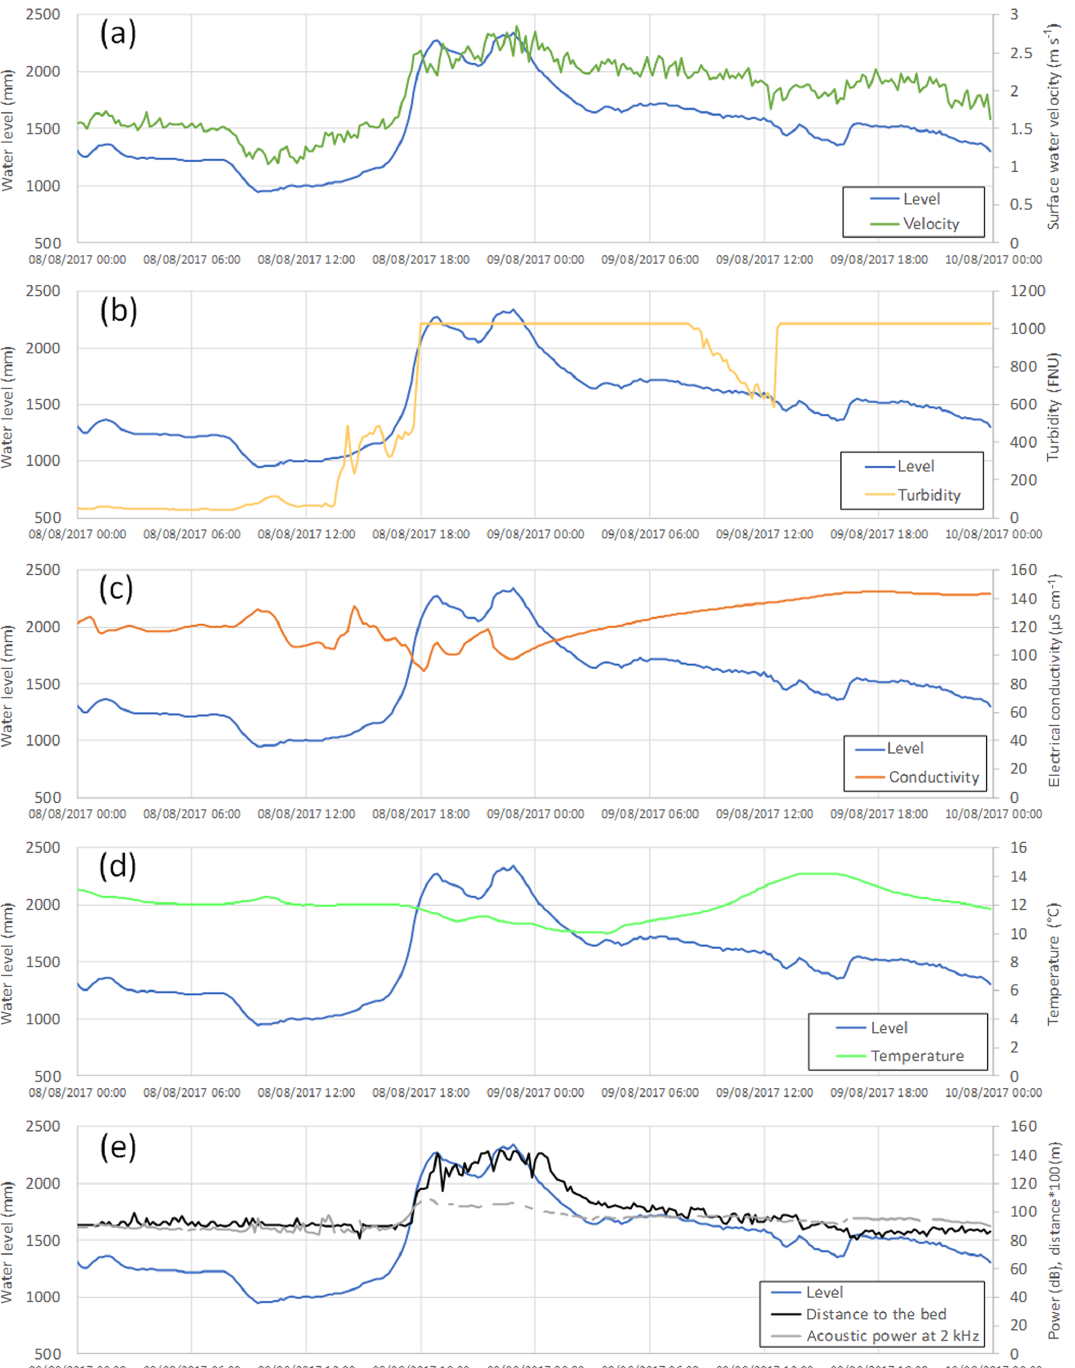
Figure 14. Raw data derived from the “Riple_DATA.txt” file for the 8 to 9 August 2017 in Bourg d’Oisans (Romanche river). (a) Time series of water level and surface water velocity. (b) Time series of water level and turbidity (SuSix MJK). Due to an inappropriate parameterization of the sensor, there is saturation of the signal above 1000FNU. (c) Time series of water level and electrical conductivity. (d) Time series of water level and temperature. (e) Time series of water level, distance from the echo sounder to the riverbed and acoustic power at 2kHz measured by the